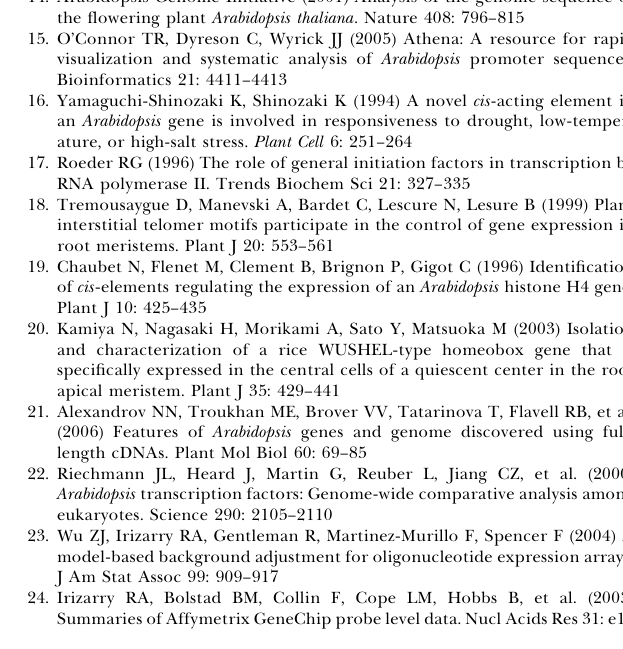
Figure S3. Correlation of the Length of the Intergenic Space in Nucleotides Preceding Genes with Their Breadth of Differential Gene Expression Response